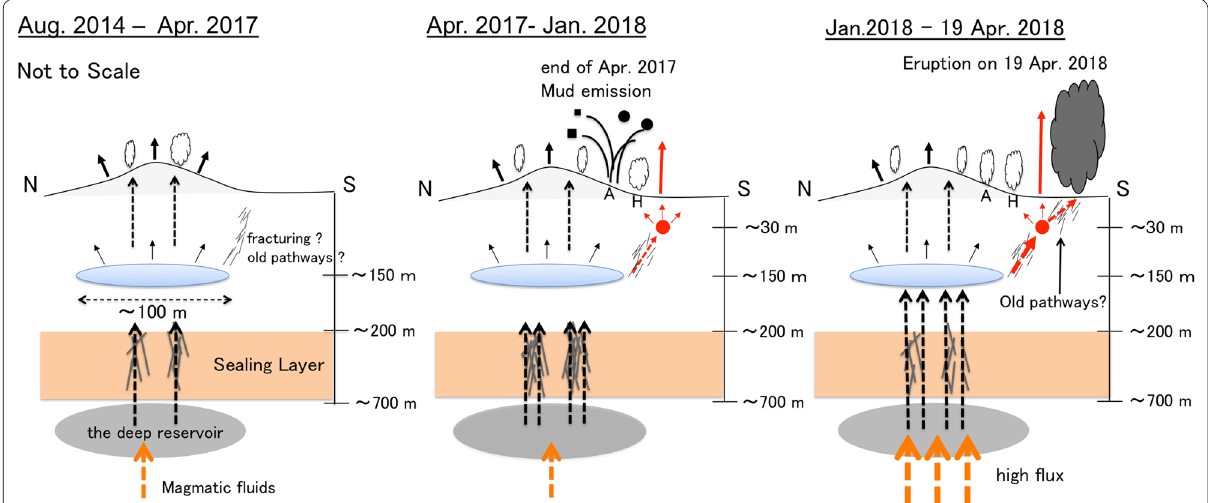
Fig. 10 Schematics illustrating the pre-eruptive process at the shallow hydrothermal system beneath Iwo-yama. Solid arrows indicate displacements of ground surface and pressure sources. Dashed arrows show subsurface fluid migration. Black and red colors indicate events before and after the mud emission in April 2017, respectively. The blue ellipsoid corresponds to the pressurized crack. The red circle corresponds to the shallower inflation source manifested since April